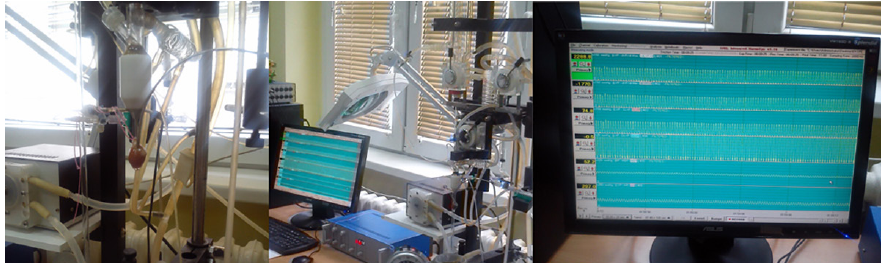
Fig. 1 - Immediately after the restoration of normal heart rhythm, through the created entrance to the left atrium of the heart and damaged mitral valve, the sensor was inserted into the left ventricle for continuous monitoring of cardiac